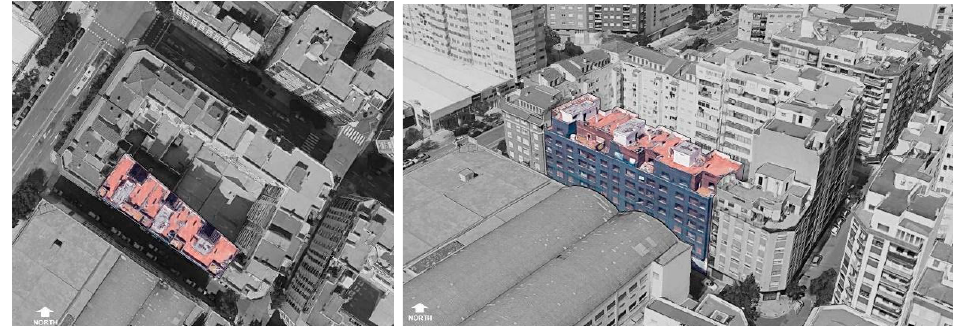
Figure 3. Panoramic view of the building—Main façade is oriented to the southwest according to urban plot. Source: [31].